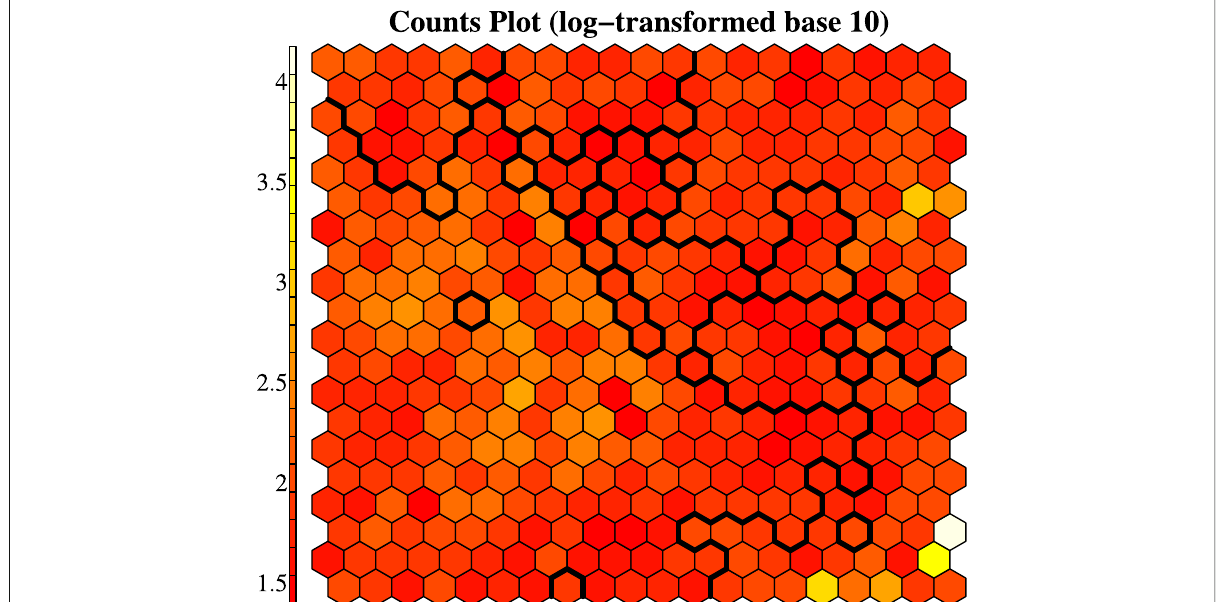
Fig. 5 Counts plot. Displays the number of input data points mapped to each